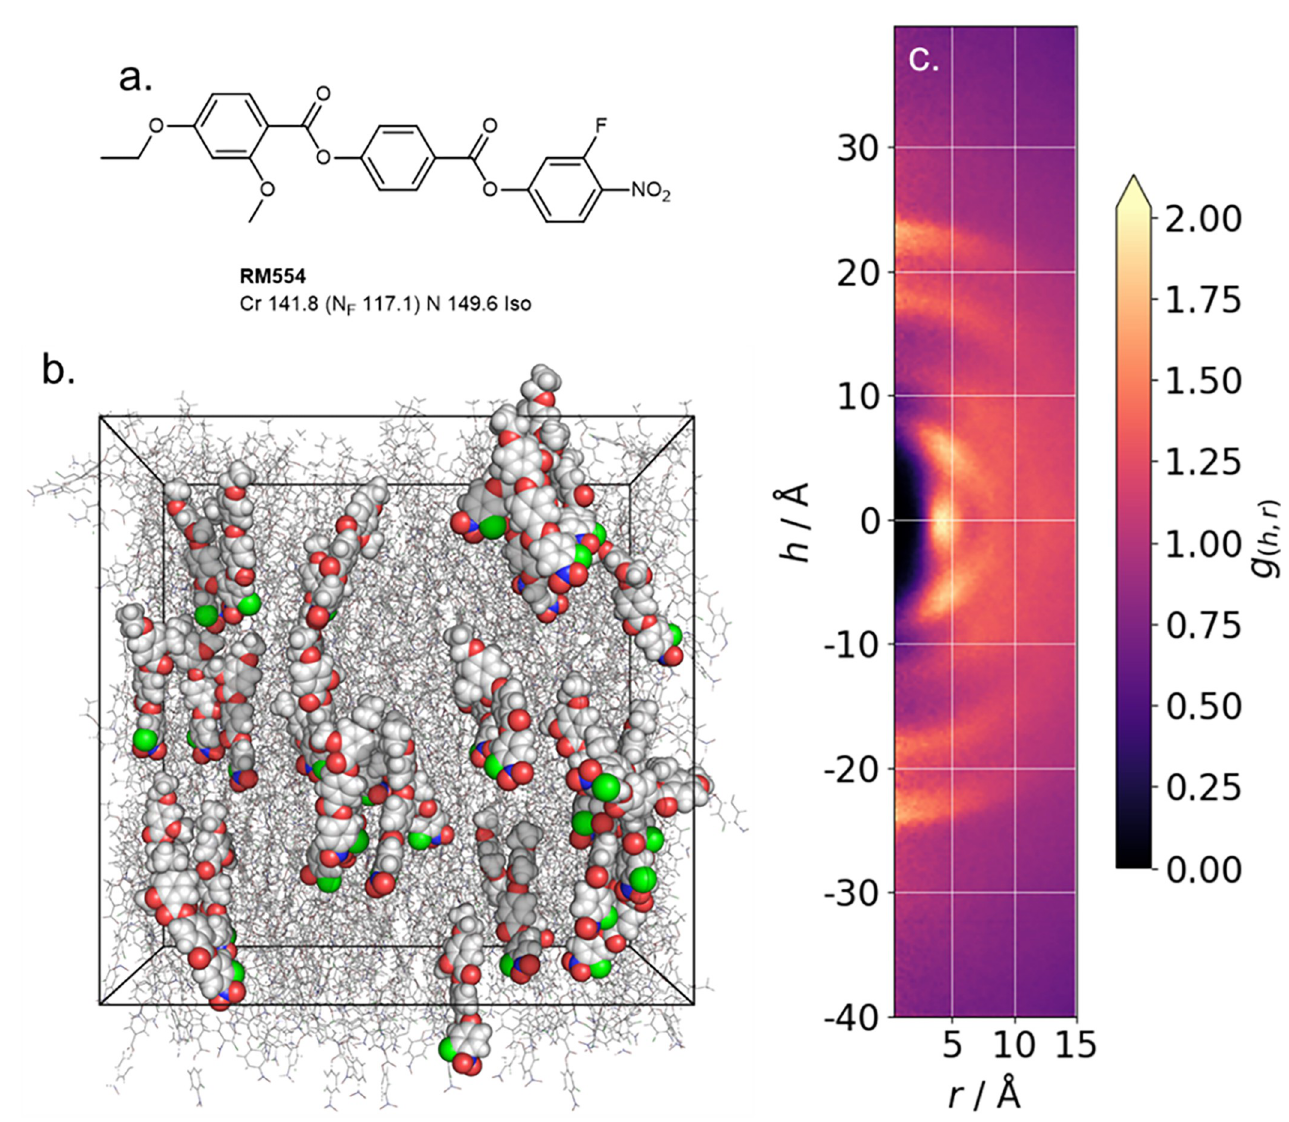
Fig 3. (a) Molecular structure and transition temperatures (˚C) of RM554 [39]; (b) instantaneous configuration of RM554 in the polar nematic configuration at 375 K, the simulation has the following average properties over the 250 ns MD run: < P 1 > = 0.92 ± 0.014 < P 2 > = 0.66 ± 0.014, Ps = 6.8 ± 0.03 μ C cm 2 ; (c) CDF for the polar nematic configuration of RM554 as generated by cylinder